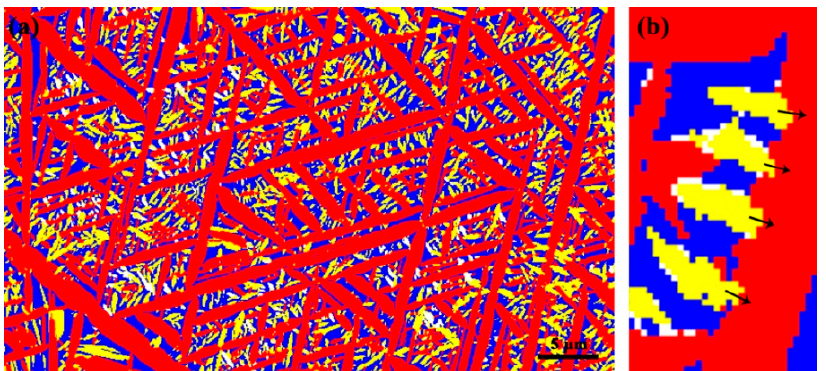
Figure 2. ( a ) Phase map of the present alloy after heat treatment in β phase field followed by AC (air-cooling). The red color is α 2 ′ , the blue is the β matrix and the yellow denotes γ phase. The step size is 50 nm. ( b ) A local part of the phase map shows the slight penetration of the γ laths into the α 2 ′ laths, as shown by the arrows. Table 1. Chemical composition of various phases in the AC sample by EDS (energy dispersive spectrometer). Element